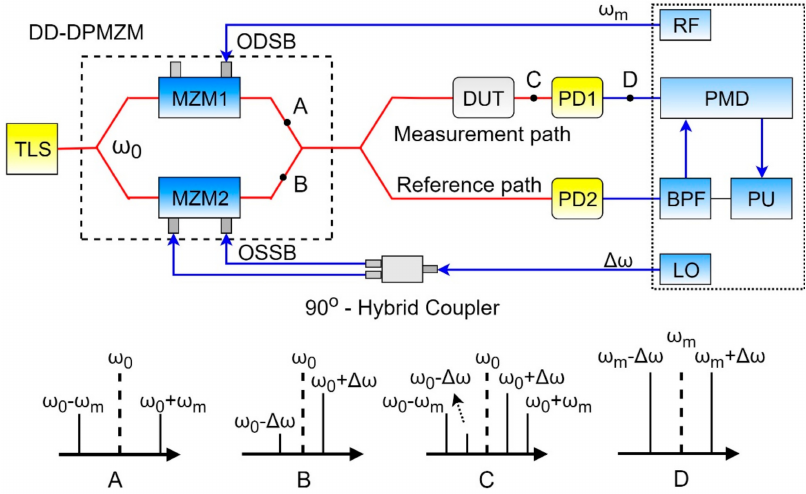
Figure 9. The schematic diagram of the OVA based on asymmetric ODSB and DD-DPMZM: TLS—tunable laser source; MZM—Mach–Zehnder modulator; DD-DPMZM—dual-drive dual-parallel MZM; DUT—device under test; PD—photodetector; RF—radio frequency;